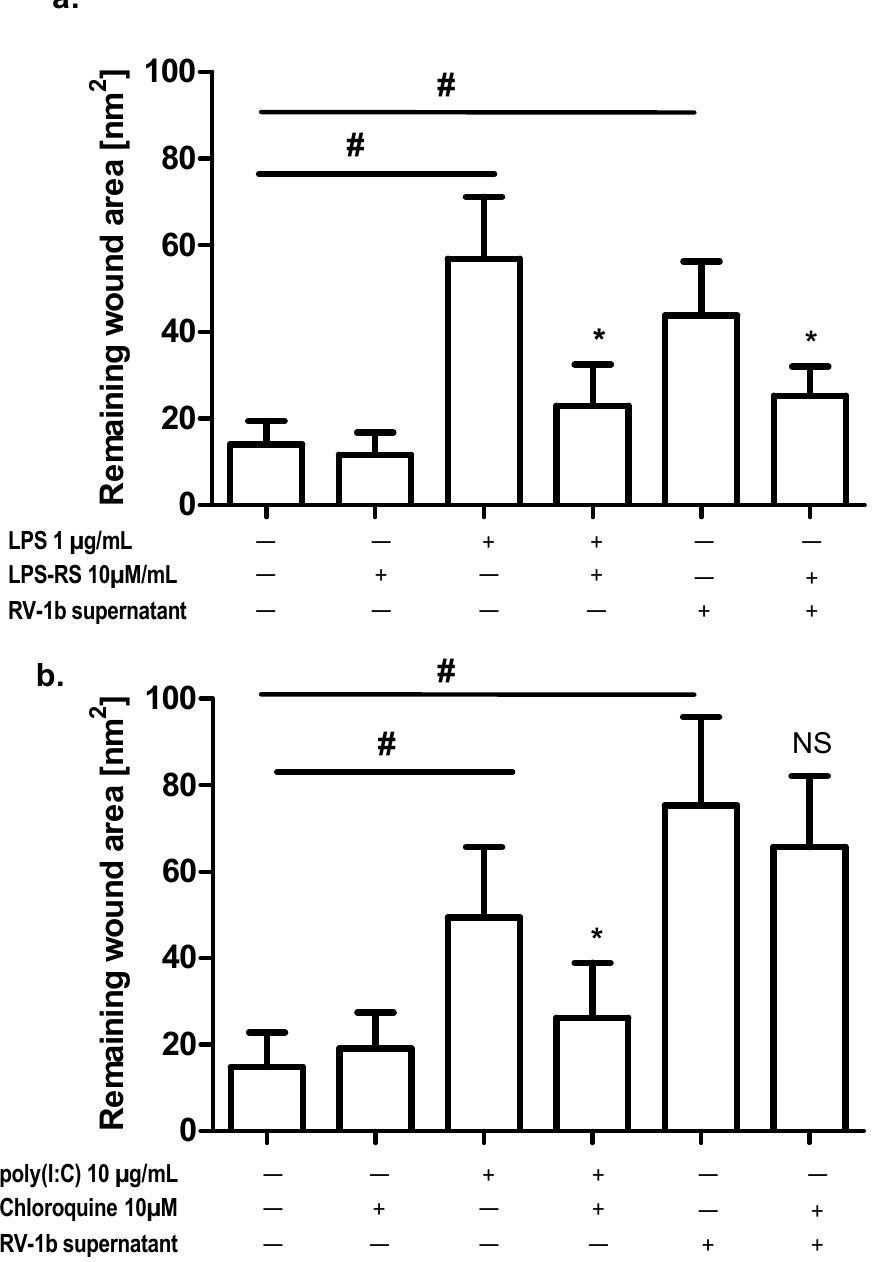
Figure 6. Effect of TLR4 and TLR3 inhibitors on wound repair; ( a ) TLR4 inhibitor LPS-RS; ( b ) TLR3 inhibitor chloroquine. * p < 0.05; # p < 0.05; NS: no statistically significant difference.